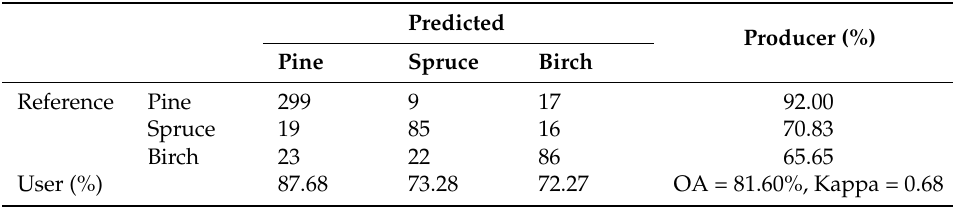
Table 6. Confusion matrix and accuracy evaluation of classification with 15 selected multi-channel intensity features and test